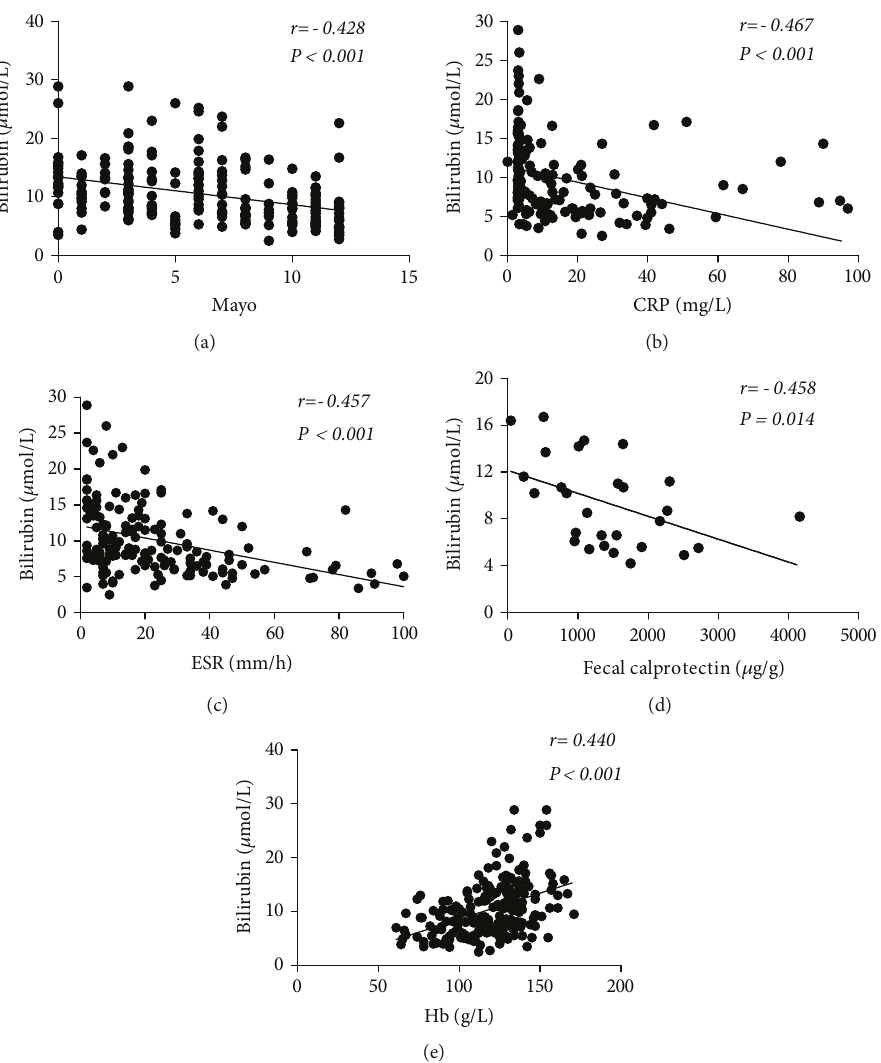
Figure 3: The correlation between the serum bilirubin level and (a) Mayo score ( n = 211 ), (b) CRP level ( n = 162 ), (c) ESR ( n = 155 ), (d) FC ( n = 28 ), and (e) Hb level ( n = 210 ) in UC patients by using a scatter